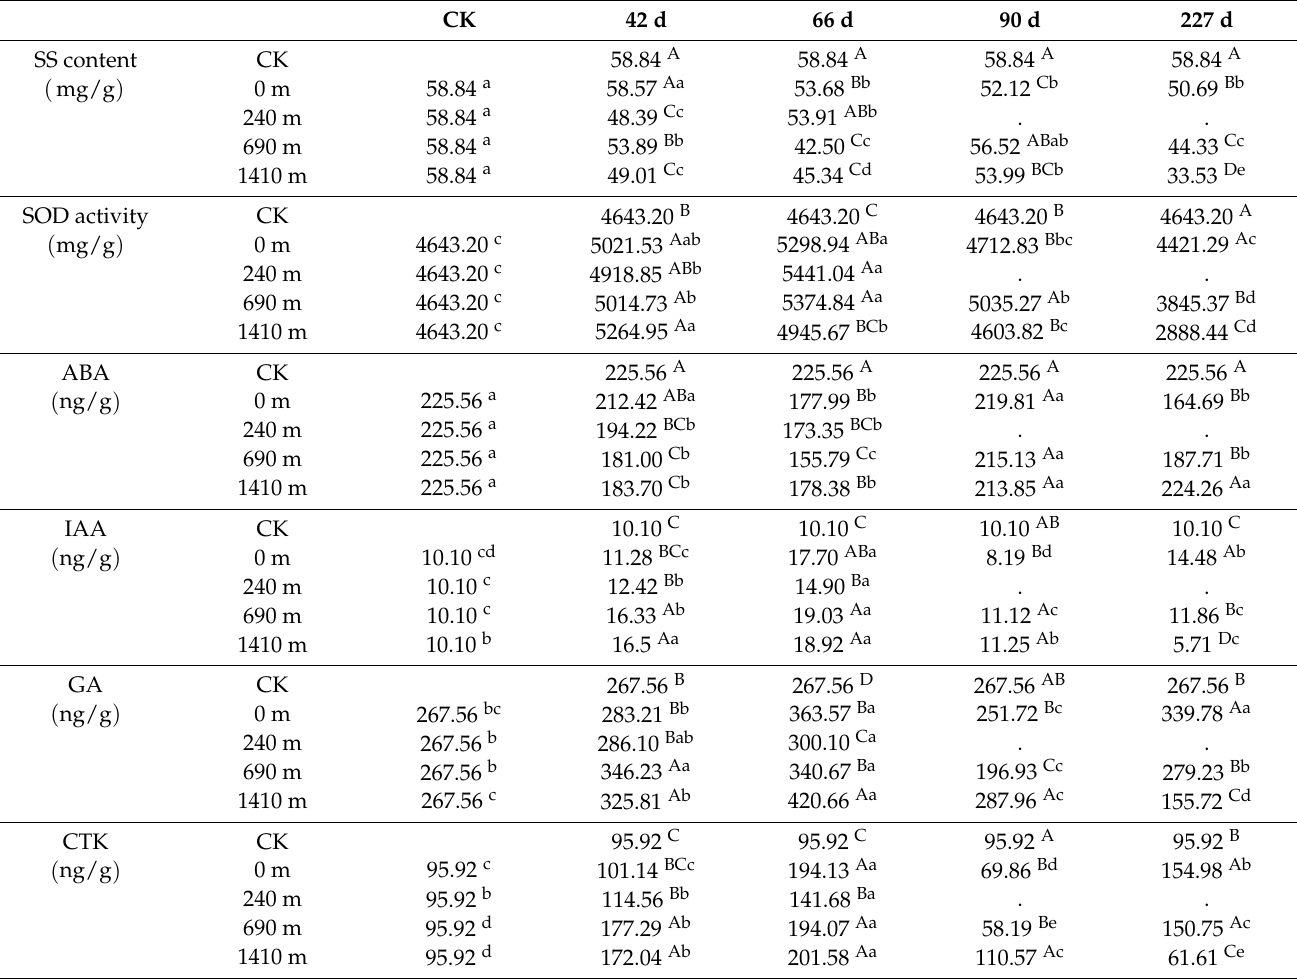
Table 2. Biochemical indicators related to germination